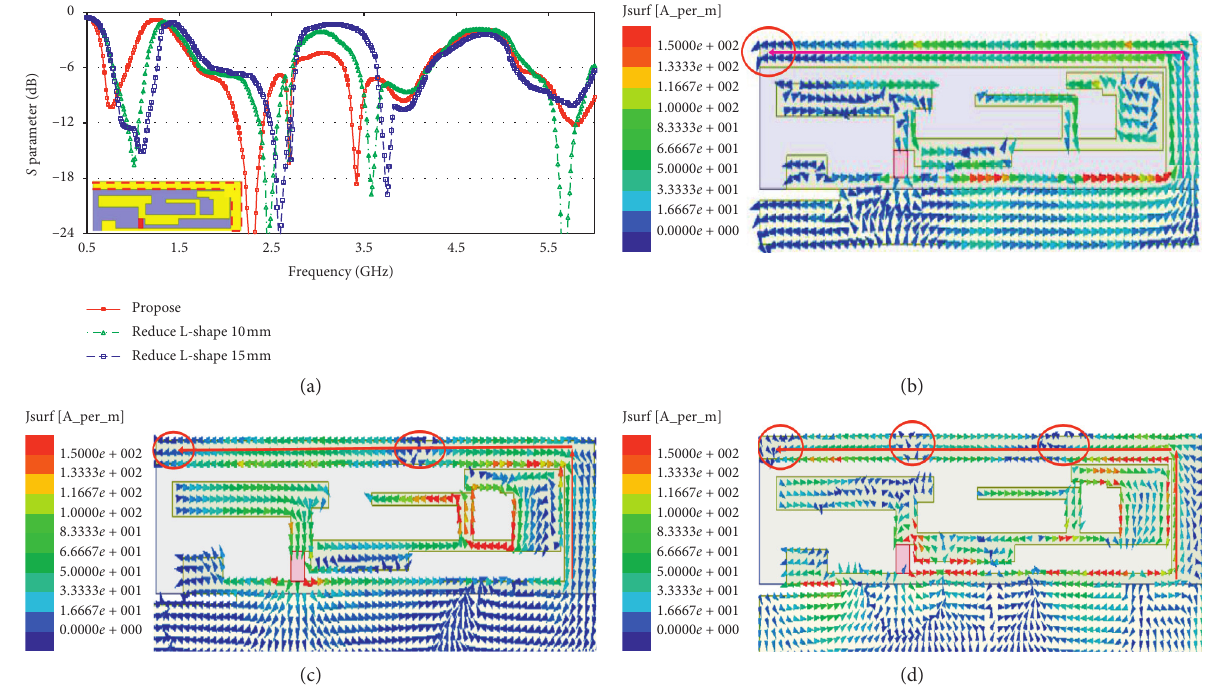
Figure 4: (a) S 11 values derived from simulation for various lengths of the coupled-fed arm of the developed antenna; couple-fed arm’s current distribution at (b) 0.76, (c) 2.34, and (d) 3.4GHz.